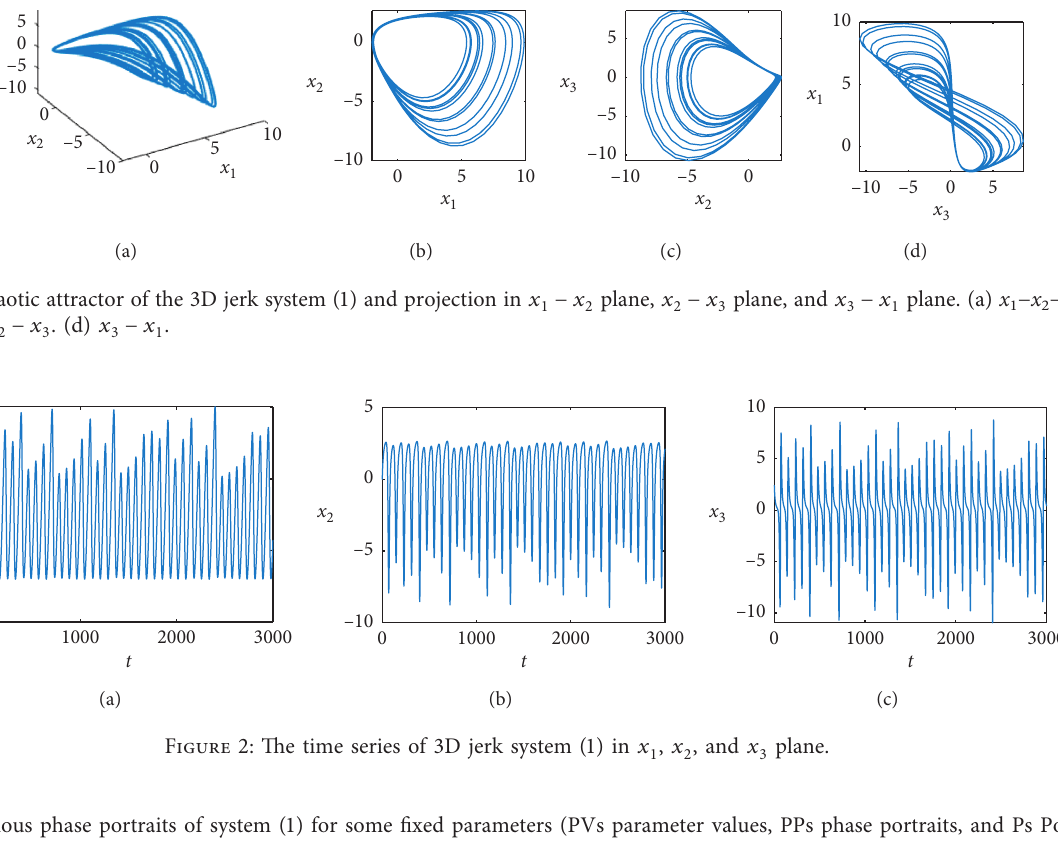
− x plane. (a) x 1 − x 2 − x 3 . (b) 3 1